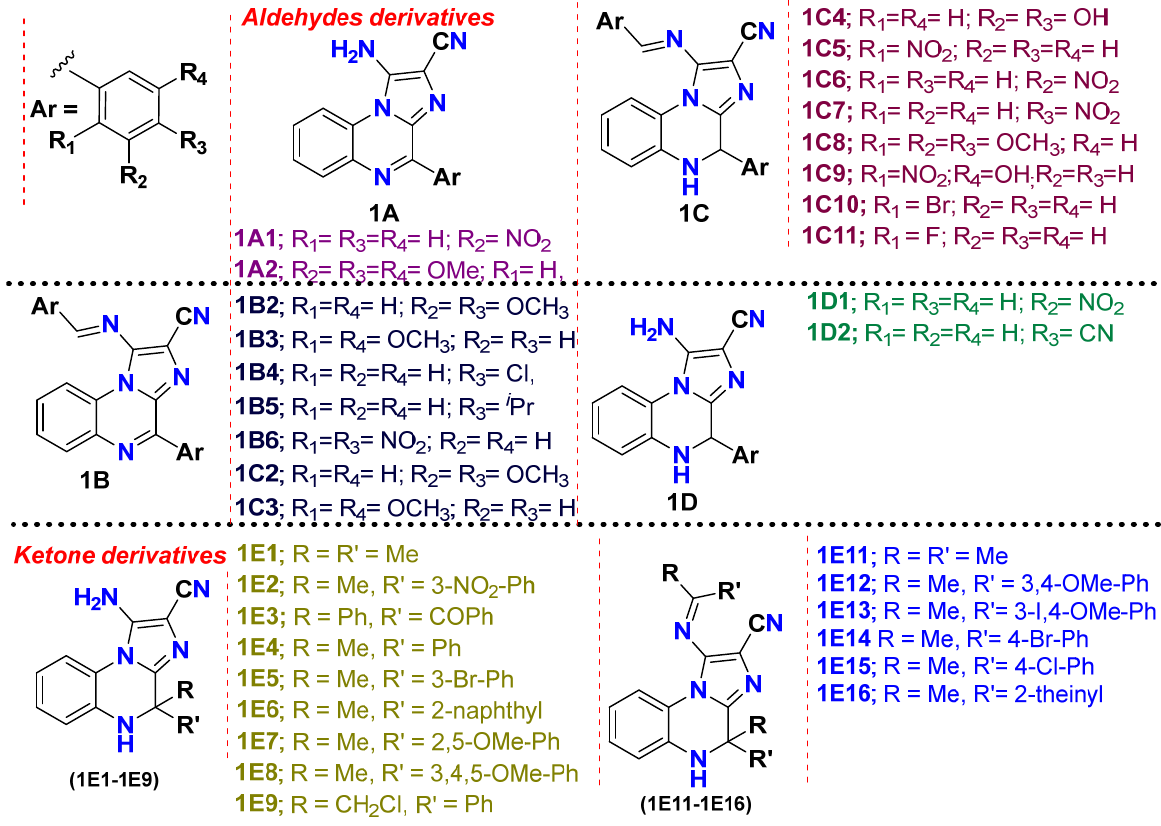
Figure 6. Selected chemical structures (34) belonging to the imidazo[1,2- a ]quinoxaline category for the present work. the present